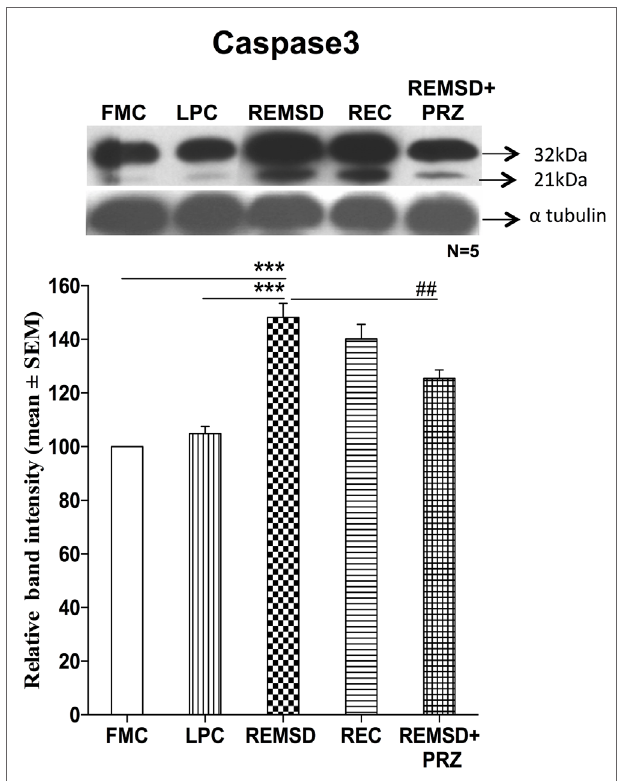
FigUre 5 | caspase9 expression in the brain homogenate of rats under different conditions . Upper panel shows a representative Western blot of caspase9. Histogram in the lower panel shows percent changes in the mean ( ± SEM) band densities of the blots as compared to FMC taken as 100% in five sets of experiments. Abbreviations are as in the text. Significance levels are between the treatments of connecting horizontal bars; *** p < 0.001 and ## p < 0.01, * as compared to FMC and # as compared to